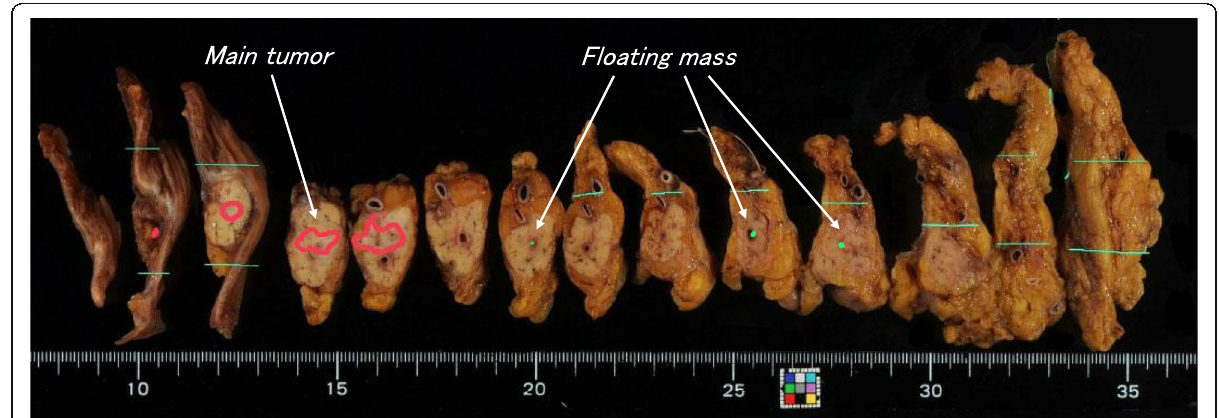
Fig. 4 Resected specimens in the second surgery. Recurrence of ITPN was observed in the pancreatic duct at a distance of 2.5 cm from the pancreatic stump. Three tumor masses were observed in the main pancreatic duct at sites distant from the main tumor